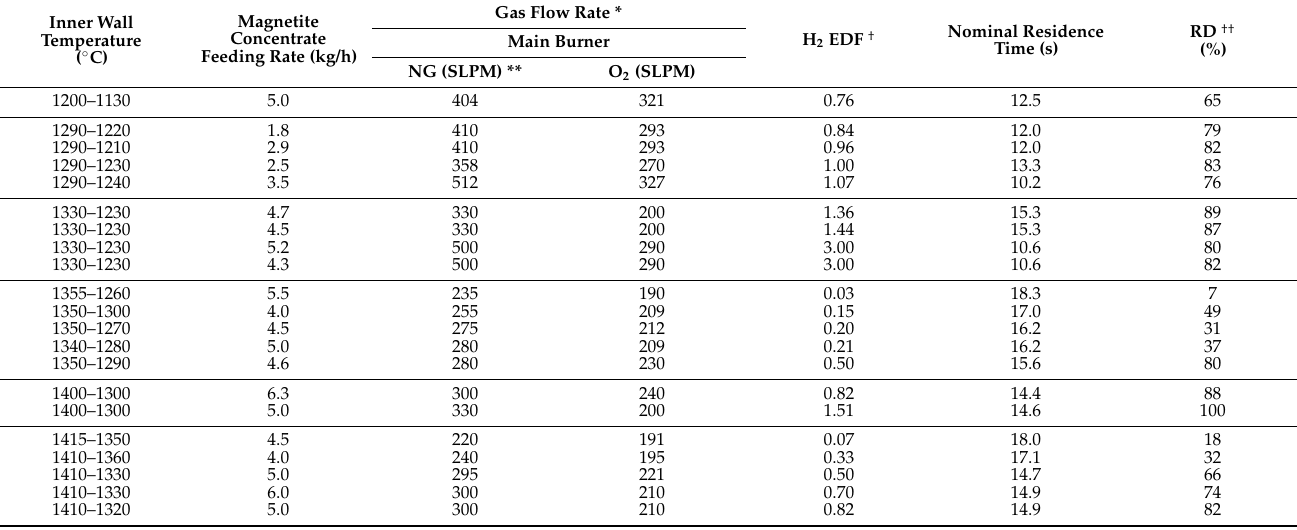
Table 2. The results of runs performed in the pilot flash reactor